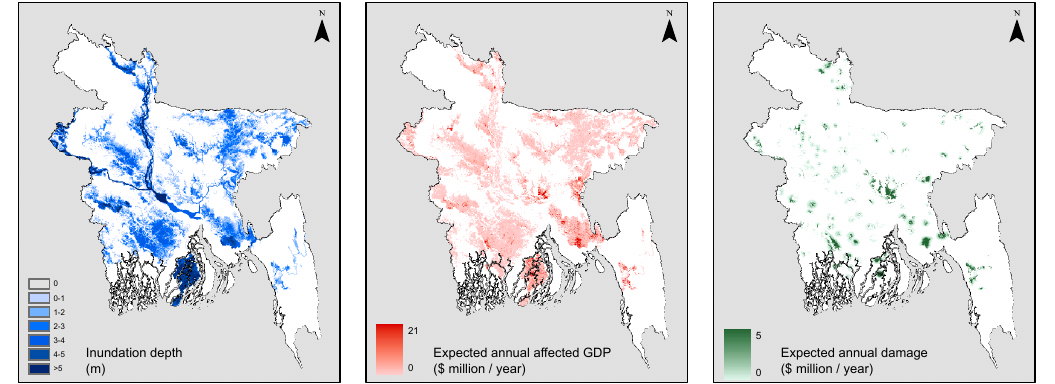
Fig. 3. From left to right: the 30yr flood, downscaled to Bangladesh; the expected value of annual damage (land use method); and the expected value of annual affected GDP (population method), based on the reference climate (1961–1990) and the current population, land use, and